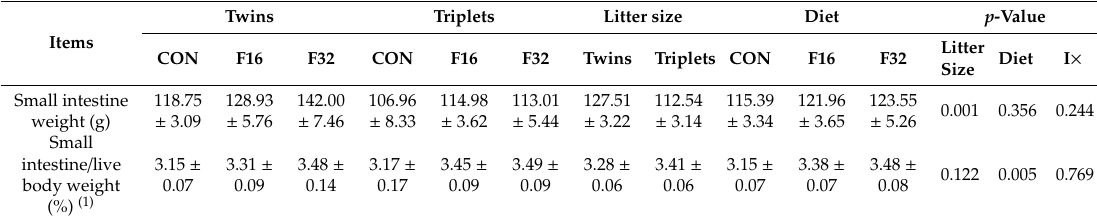
E ff ect of dietary folic acid supplementation during gestation on intestinal index of newborn lambs.